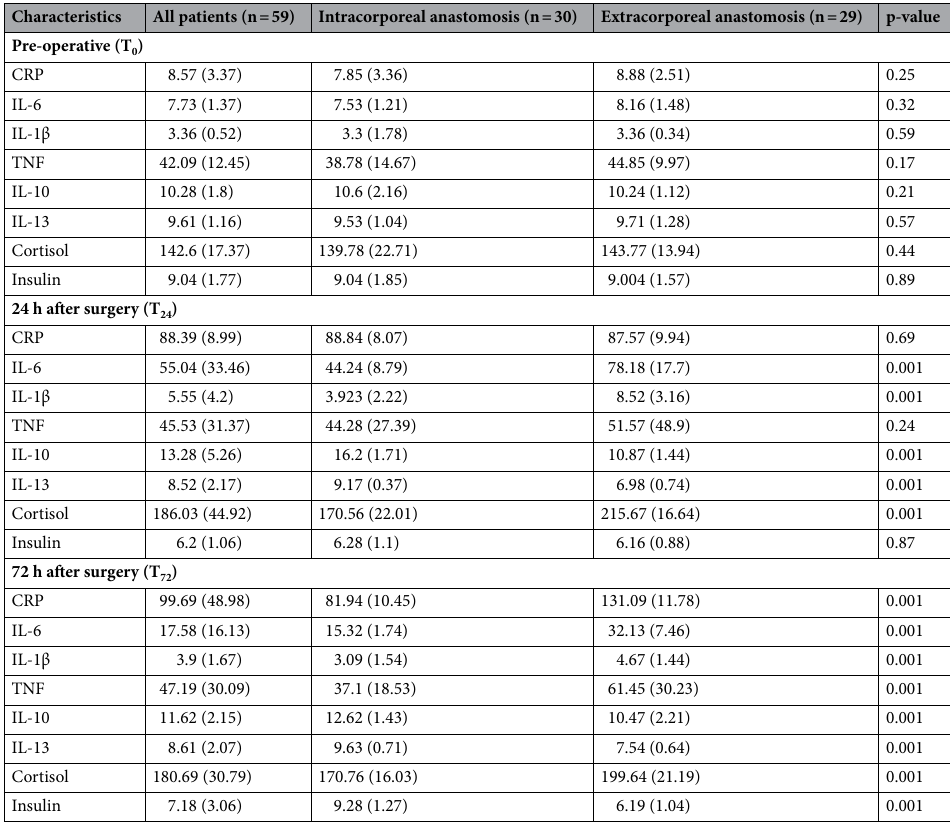
Table 2. Inflammatory mediators in all randomized patients. Data were expressed as median (interquartile range). CRP C-reactive protein, TNF tumor necrosis factor, IL Interleukin.